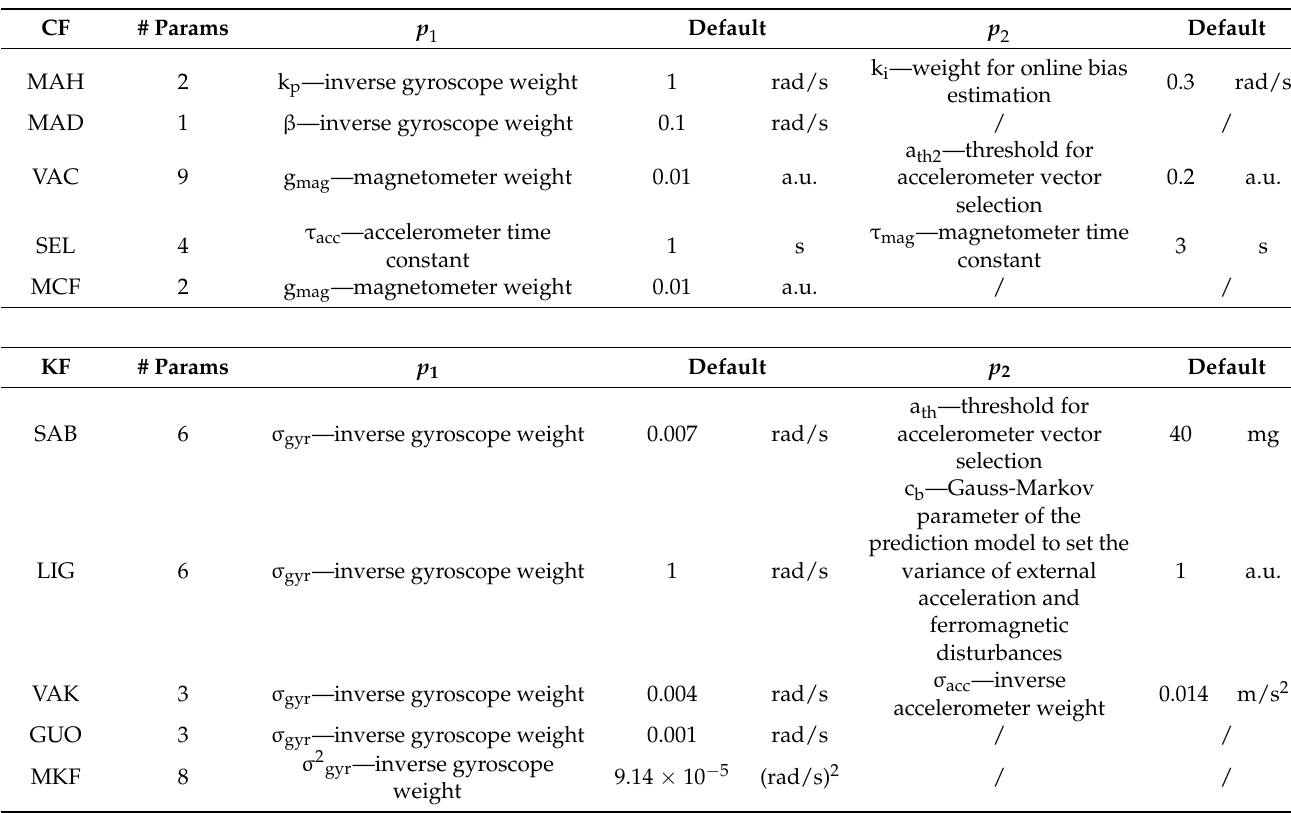
Table 1. This table reports the details of the two parameters selected for optimal and suboptimal tuning along with their default values. Adapted from